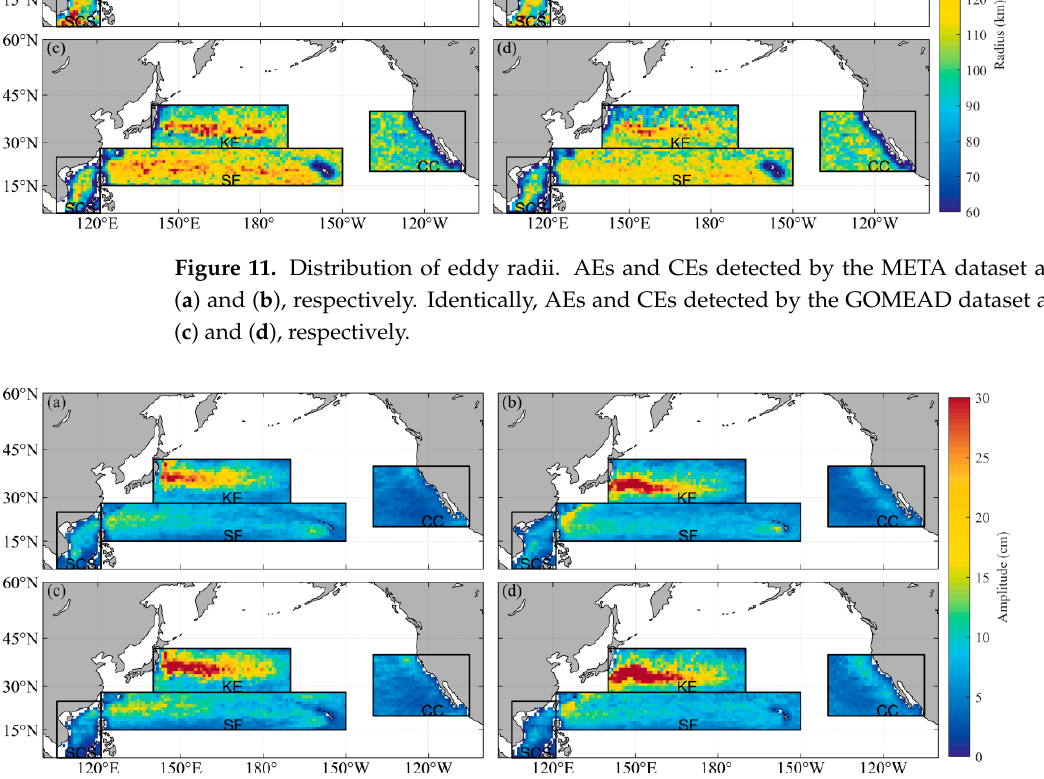
Figure 11. Same as Figure 9, but for eddy radii.